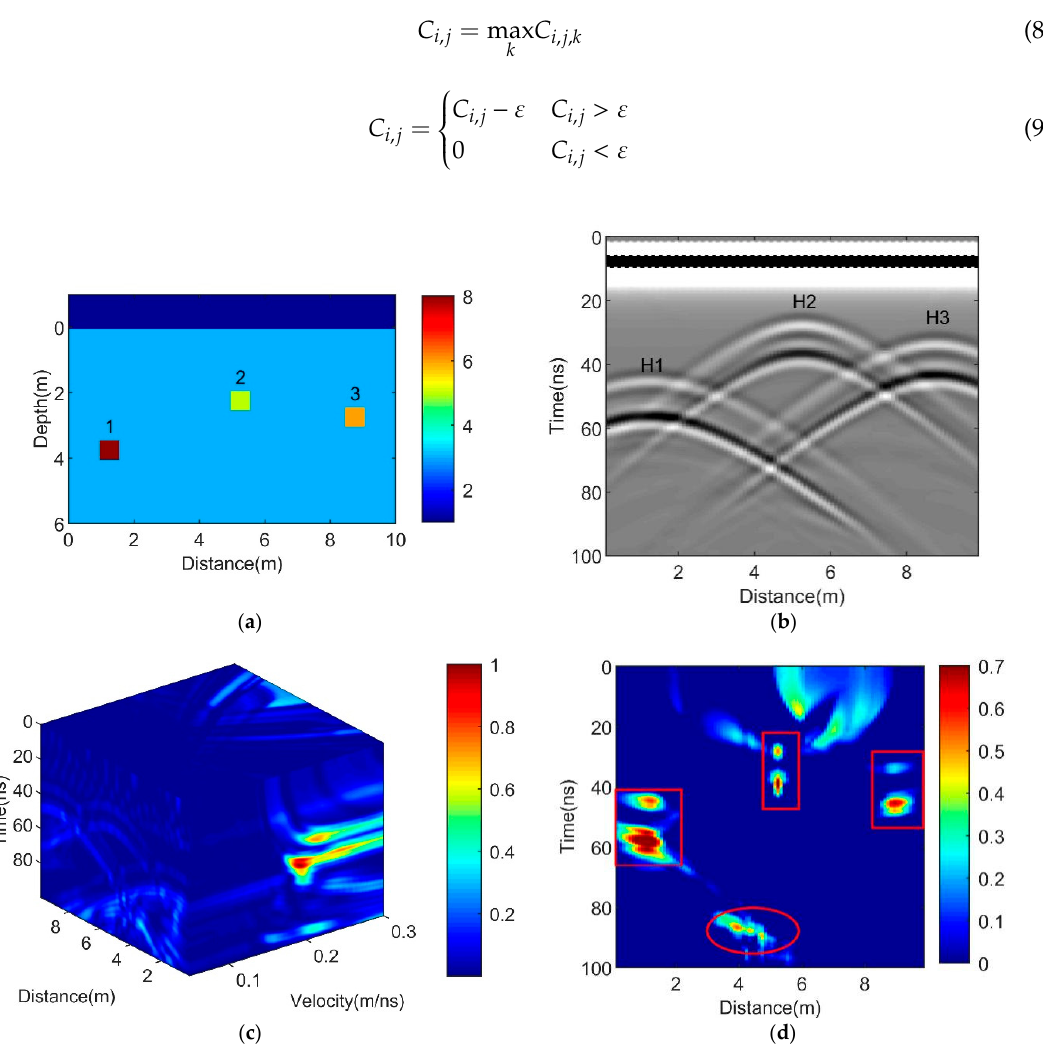
Figure 1. Model test results. ( a ) The model used in simulation; ( b ) the simulated GPR profile; ( c ) 3D velocity spectrum of ( b ); ( d ) maximum value along velocity axis with the soft threshold function processing.